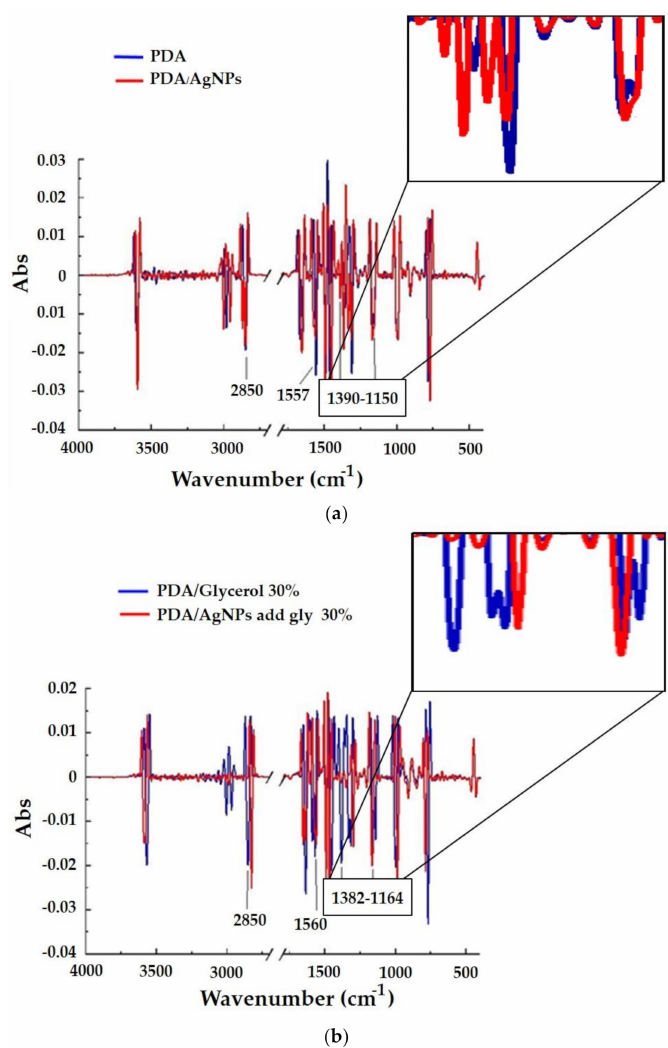
Figure 8. Second derivative Fourier-transform infrared (FT-IR) spectra of polydiacetylene (PDA), and the 1:3 PDA / silver nanoparticle (AgNP) ratio (prepared with 30 mg / L AgNPs) ( a ) without and ( b ) with 30% glycerol embedded in carboxymethyl cellulose (CMC)